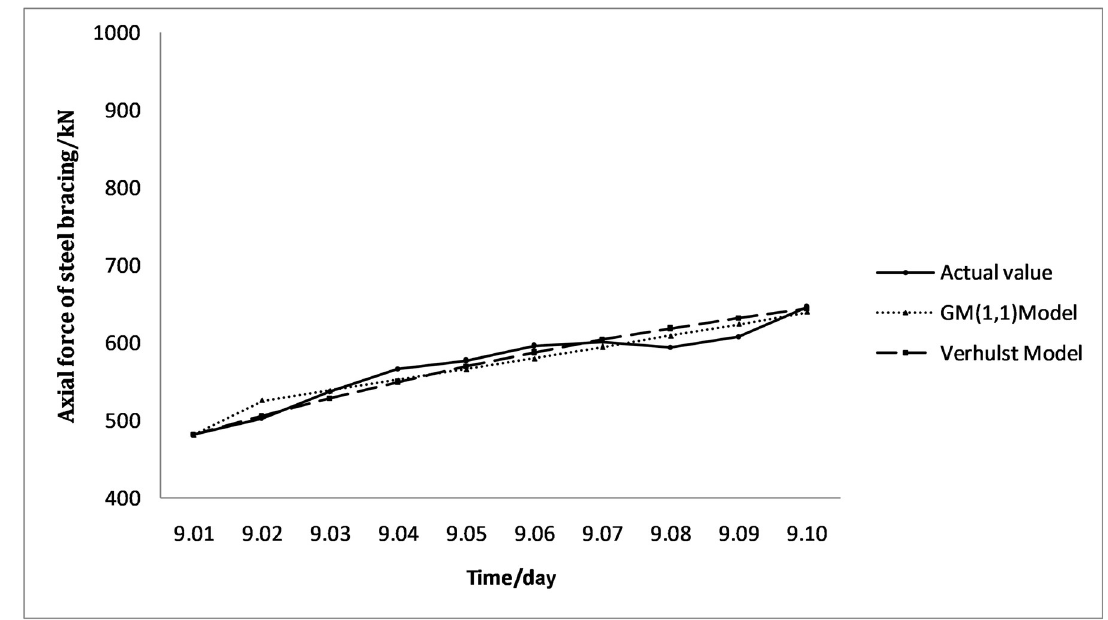
Fig 7. Comparison of ZG51-3 the actual value and the model value.